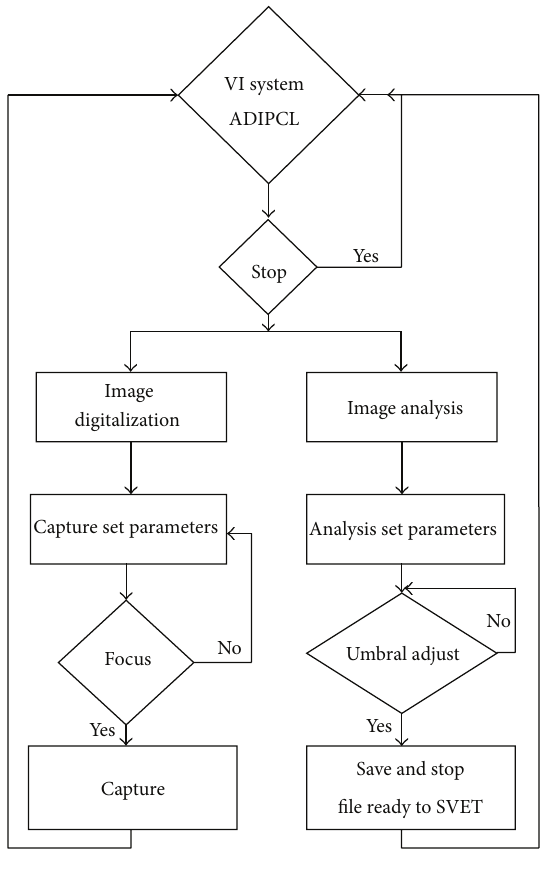
Figure 2: Flow diagram for VI